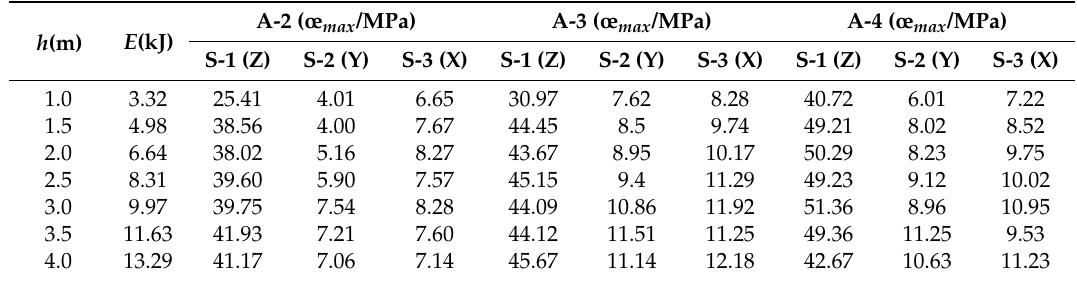
Table 2. Maximum stress values of sensors under different impact energy